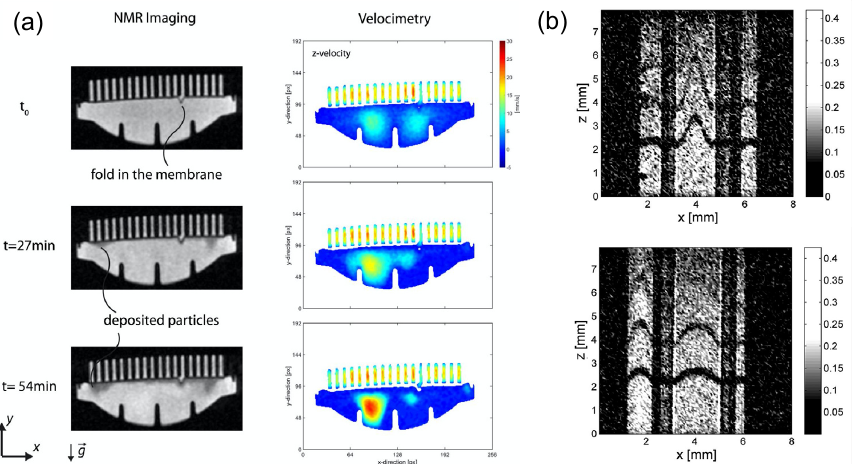
Figure 15. ( a ) MRI and flow-MRI of the commercial filtration module investigated by Wiese et al. NMR imaging clearly shows the presence of a cake layer after 54 min of filtration (darker areas). ( b ) MRI saturation stripes indicating axial velocity inside and outside a single hollow fiber membrane. Images show the effects of the absence (top) and presence (bottom) of Ca 2 + ions on fouling development due to alginate deposition after 22 and 21 min [175,181] .